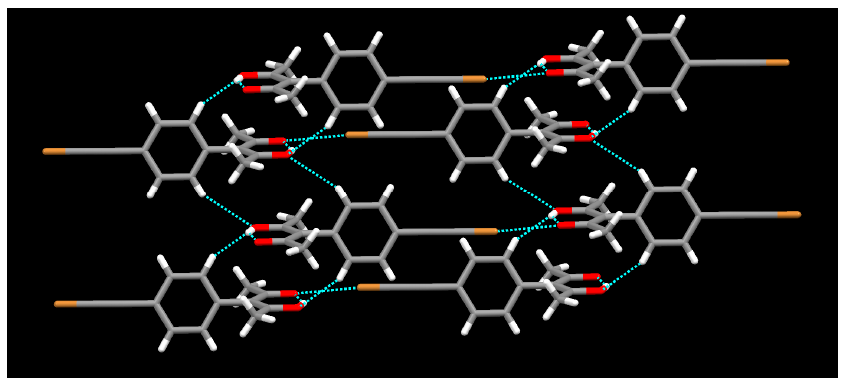
Figure 2. Part of the crystal structure of L2 (color codes: red—oxygen; gold—bromine).